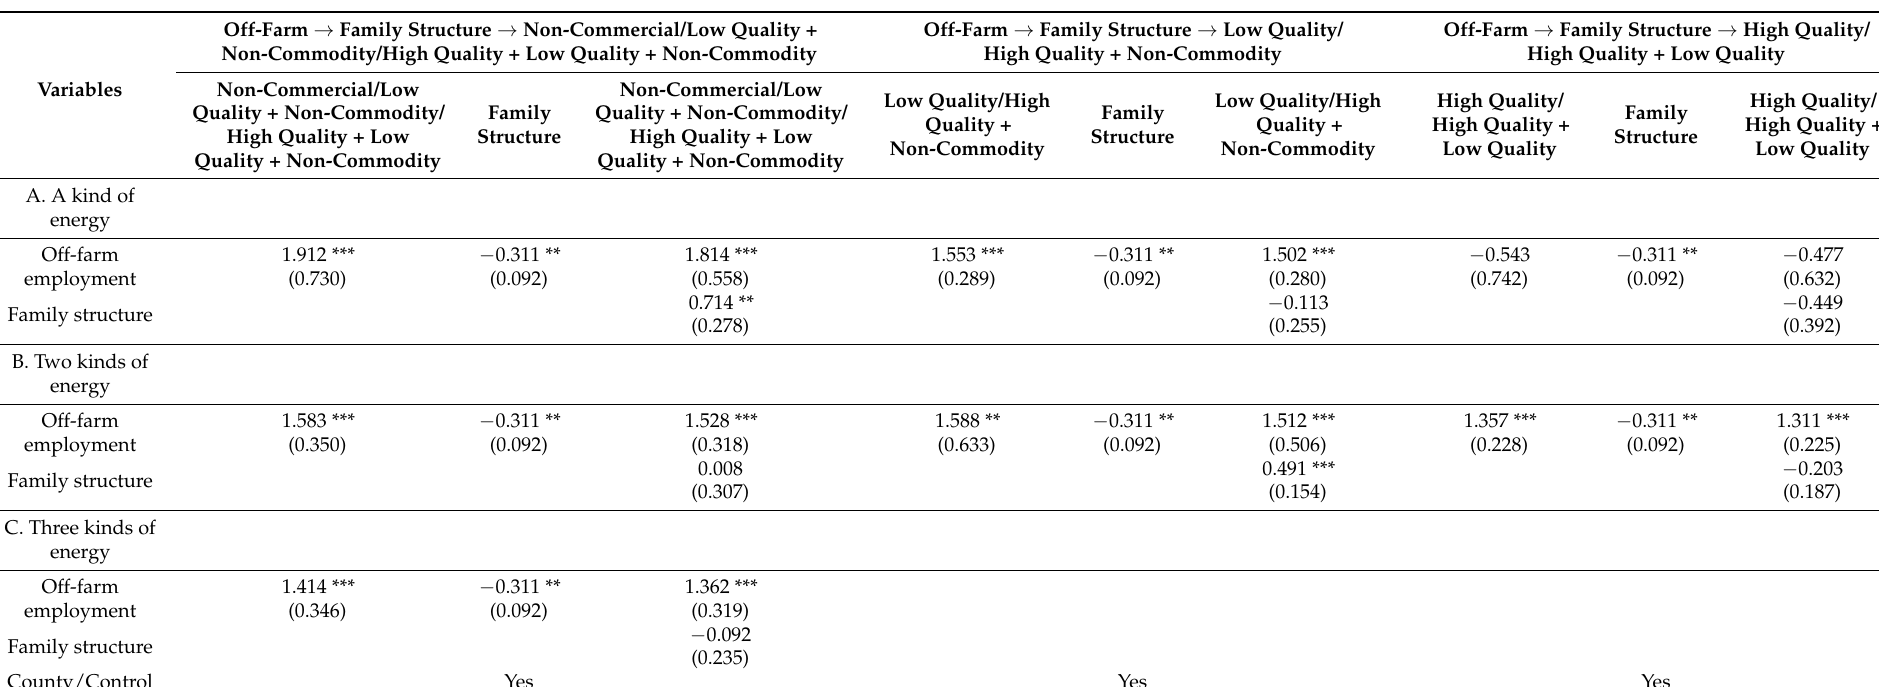
Table 6. Mechanism of the impact of Off-farm employment on several types of energy use: family demographic